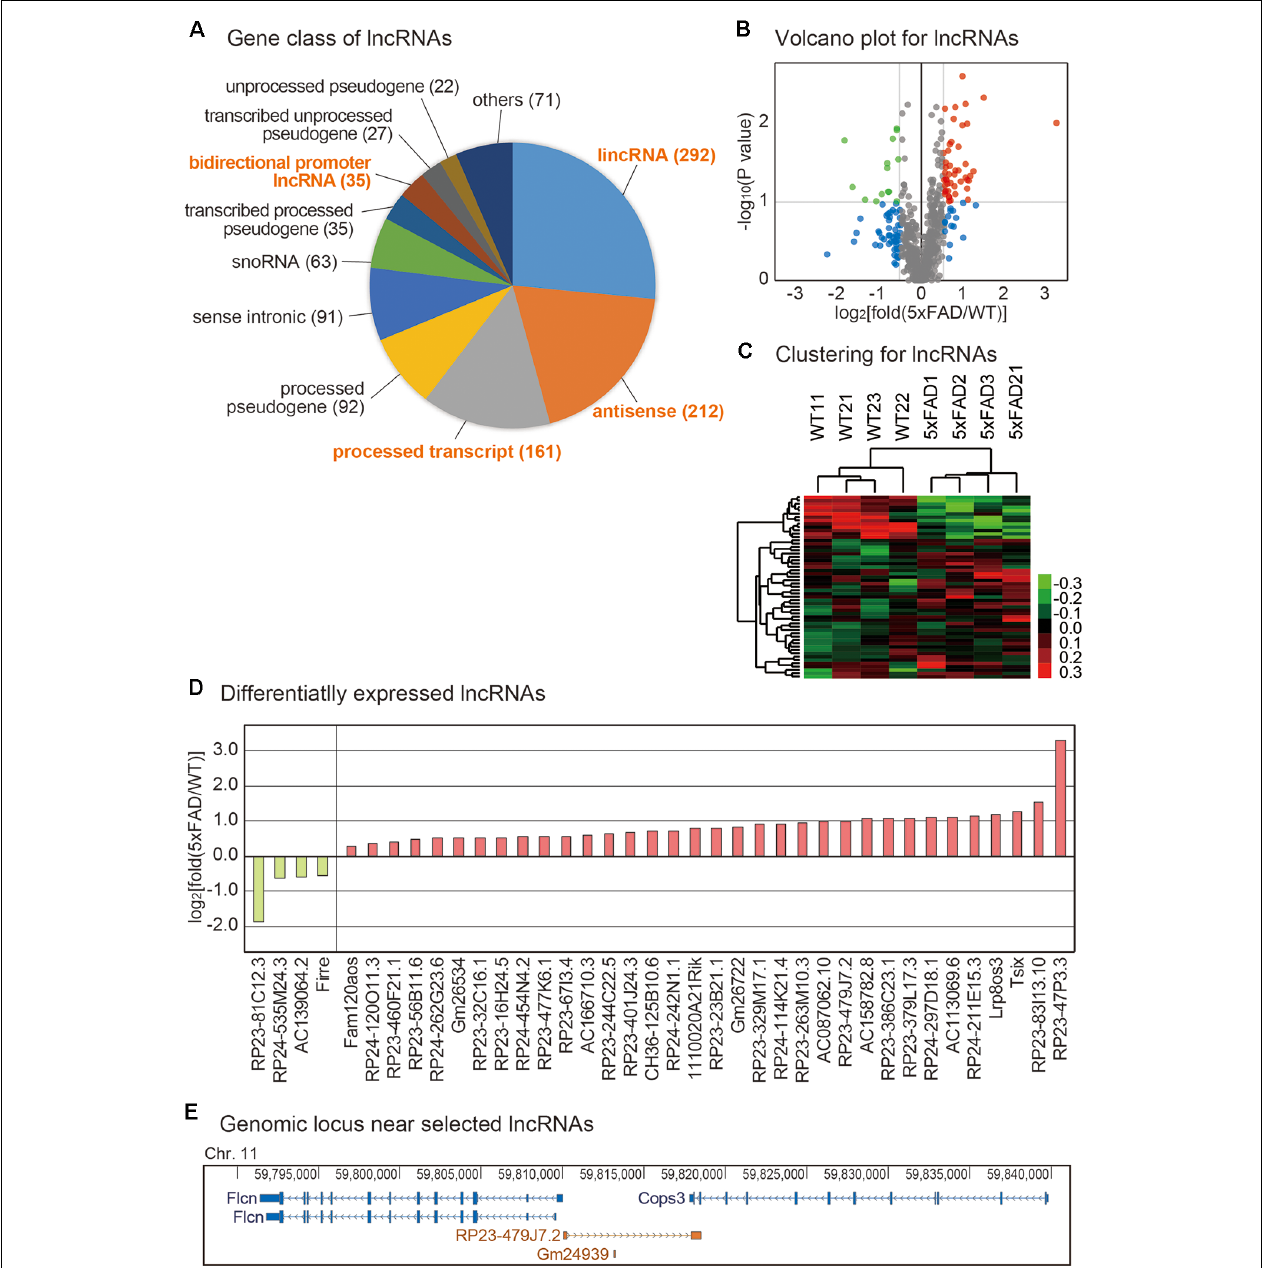
FIGURE 3 | Analysis of lncRNAs changes in the mouse pineal gland with AD. (A) Distribution of identified lncRNAs from pineal gland samples based on the GENCODE annotation. The number of identified lncRNAs for each lncRNA class is shown in parentheses. (B) Volcano plot for lncRNAs. Those genes with P -value < 0.1 and those with expression changes > 50% in the 5xFAD group compared to the wild type group are indicated with colored dots. (C) Clustering for lncRNAs. For the selected lncRNAs from (B) , unsupervised hierarchical clustering was performed. The color bar representing the expression difference between the wild type and 5xFAD groups is shown. (D) List of differentially expressed lncRNAs between the pineal gland from the wild type and 5xFAD groups. (E) Genomic information near the locus of lncRNA RP23-479J7.2 and its near protein-coding genes, Flcn and Cops3. The genomic information data were downloaded from the Genome Browser (Kent et al.,